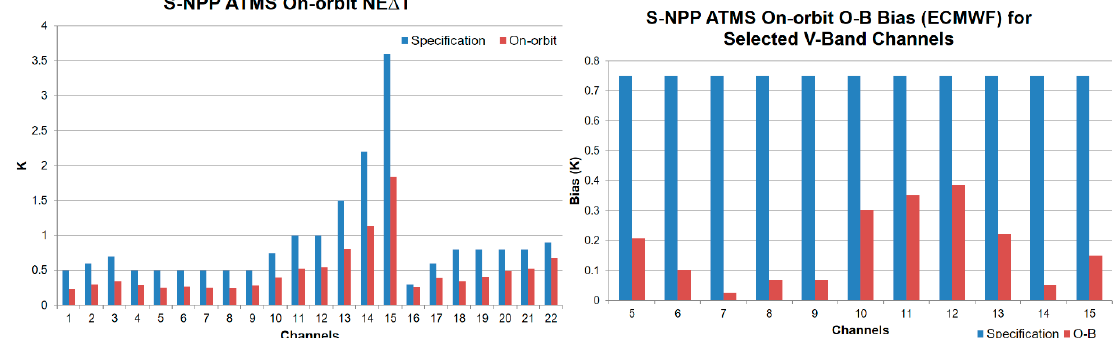
Figure 10. S-NPP ATMS SDR performance. The red and blue bars represent the NEDT on-orbit performance versus the specification for the S-NPP ATMS instrument ( left figure ). The S-NPP ATMS SDRs show smaller bias between the observed and calculated radiances using the CRTM (O-B) (red) compared to the specifications (blue) ( right figure ). These figures indicate excellent on-orbit performance of the ATMS instrument. Figures are obtained from 2016 JSTAR Annual Meeting team’s overview presentation available at the JSTAR website [4]. (Figure courtesy: Quanhua Liu, STAR ATMS SDR team). Table 9. S-NPP CrIS SDR performance*.